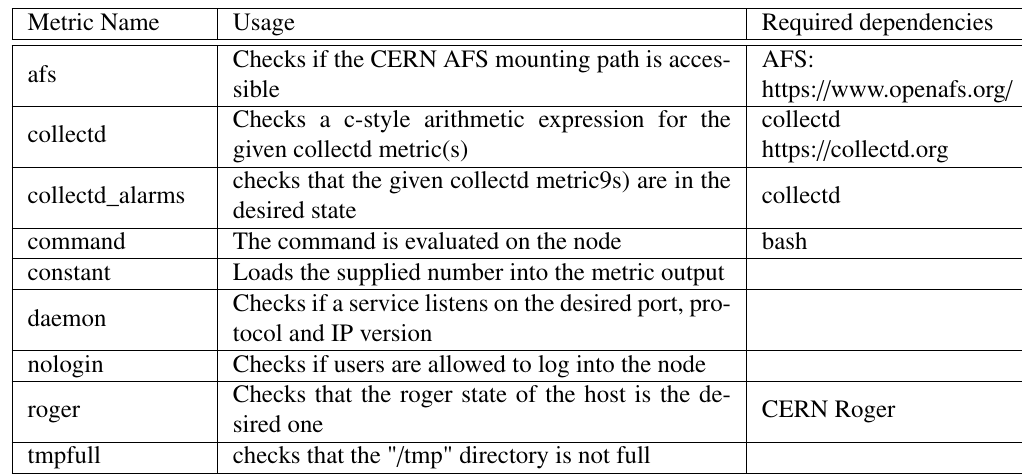
Table 1. Metrics supported by the load balancing